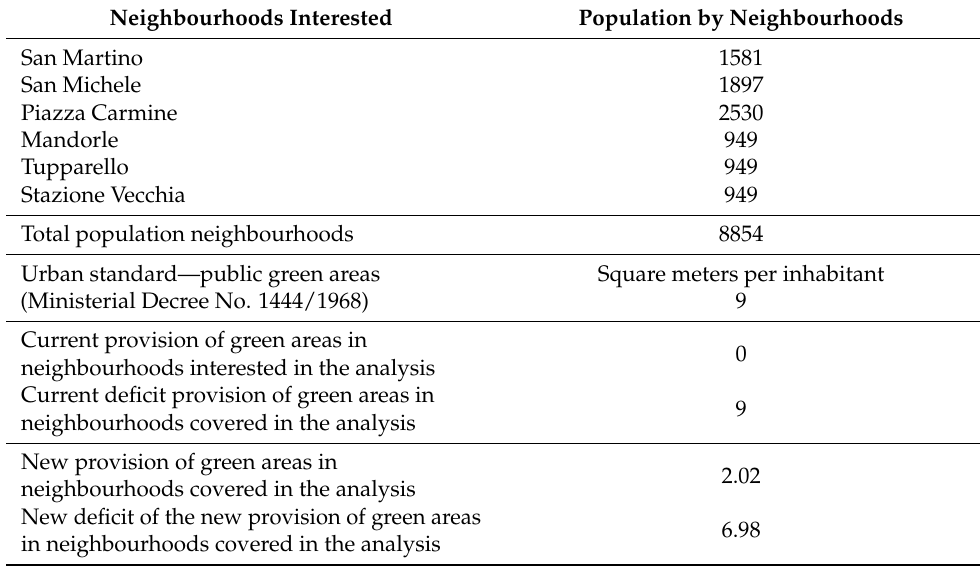
Table 2. The current and potential needs for green areas in the neighbourhoods covered by the analysis. Neighbourhoods